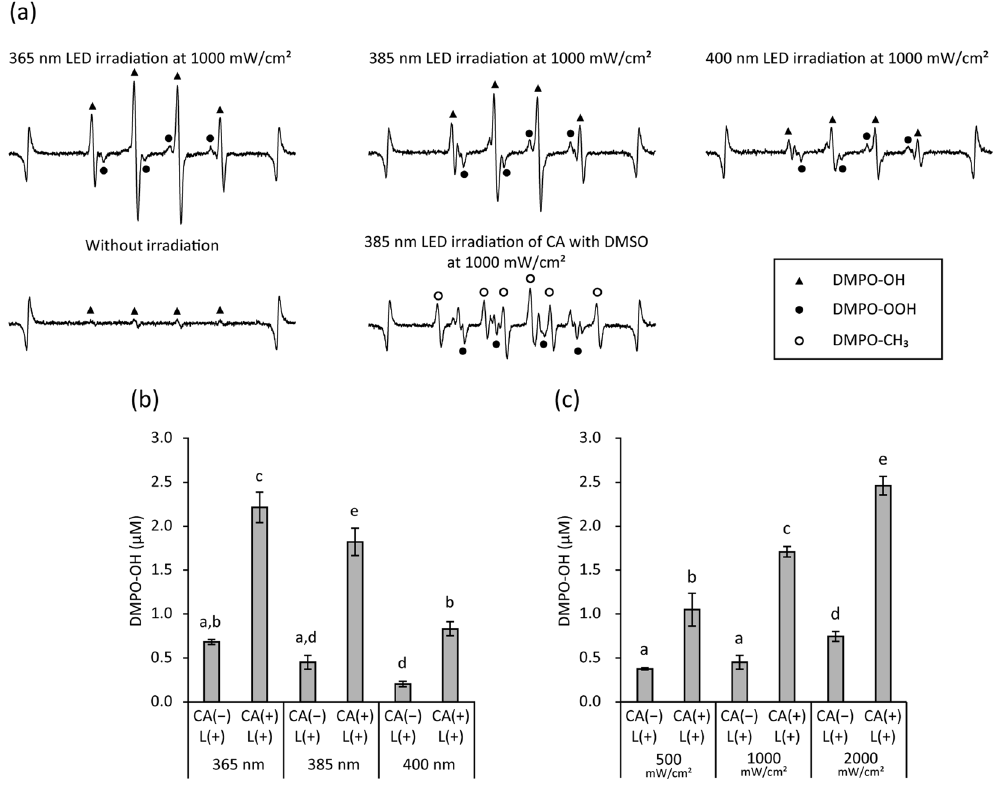
Figure 4. Analysis of hydroxyl radicals generated by LED irradiation of caffeic acid (CA) solution. Hydroxyl radicals were qualitatively and quantitatively analysed using electron spin resonance (ESR)-spin trapping technique using 5,5-dimethyl-1-pyrroline N -oxide (DMPO) as a spin trap agent. ( a ) Representative ESR spectra of DMPO-OH (spin adduct of hydroxyl radical: closed triangle) generated using each condition. DMPO- OOH (spin adduct of superoxide anion radical: closed circle) and DMPO-CH 3 (spin adduct of methyl radical: open circle) were also detected using specific conditions. The peaks at both ends represent Mn 2 + used as the internal standard. ( b ) Yield of DMPO-OH generated by a 365, 385, or 400 nm LED irradiation of 1 mg/mL CA [CA( + )L( + )] or pure water [CA( − )L( + )] at an irradiance of 1000 mW/cm 2 for 1 min. ( c ) Yield of DMPO-OH generated by a 385 nm LED irradiation of 1 mg/mL CA or pure water at an irradiance of 500, 1000, or 2000 mW/cm 2 for 1 min. Values and error bars in ( b ) and ( c ) indicate the mean and standard deviation, respectively. Different letters above the columns in ( b ) and ( c ) refer to significant differences ( p < 0.05) between different